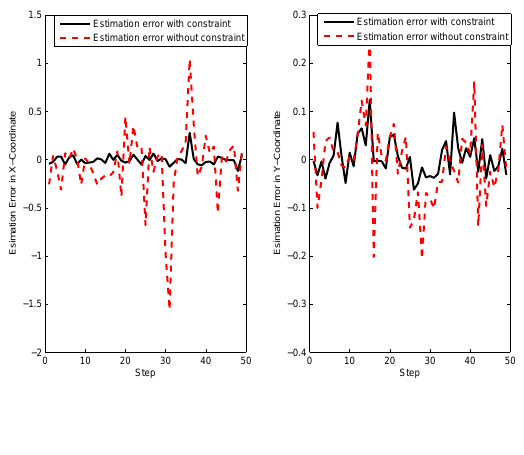
Figure 14. Estimate error of individual